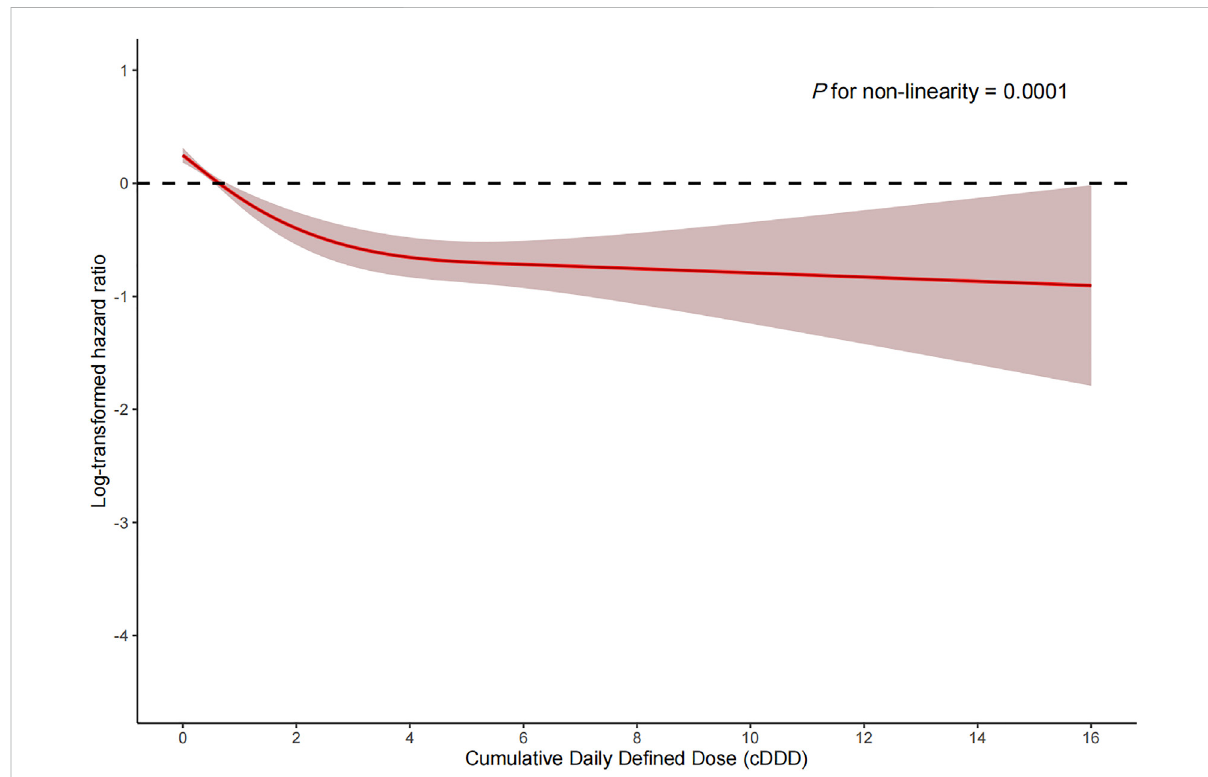
FIGURE 4 Dose-response association between the cumulative daily de fi ned dose of ACEI/ARBs and 180-day mortality. p for non-linearity = 0.0001. The solidredlinesrepresenttheeffectestimatesandtheshadedarearepresents95%con fi denceintervals.Abbreviations:cDDD,cumulativedailyde fi ned